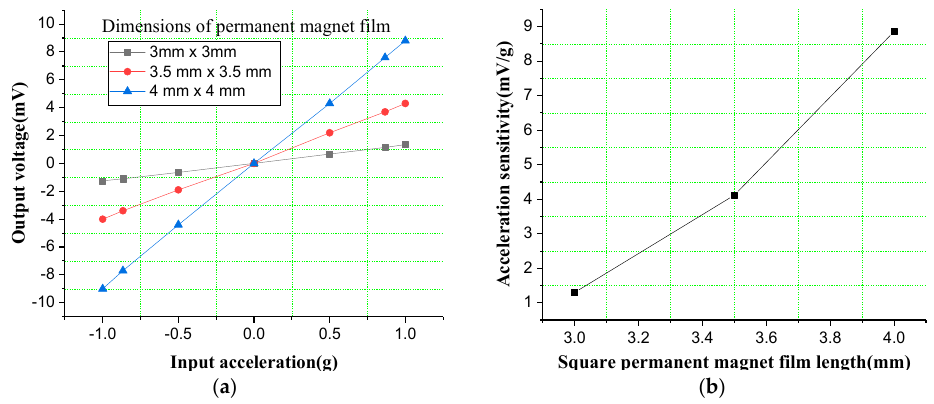
Figure 11. Acceleration input and output response characteristics under different dimensions of permanent magnetic film in the tunneling magnetoresistive accelerometer. ( a ) Input acceleration versus output voltage under different dimensions of permanent magnetic film; ( b ) The sensitivity versus dimensions of permanent magnet film.